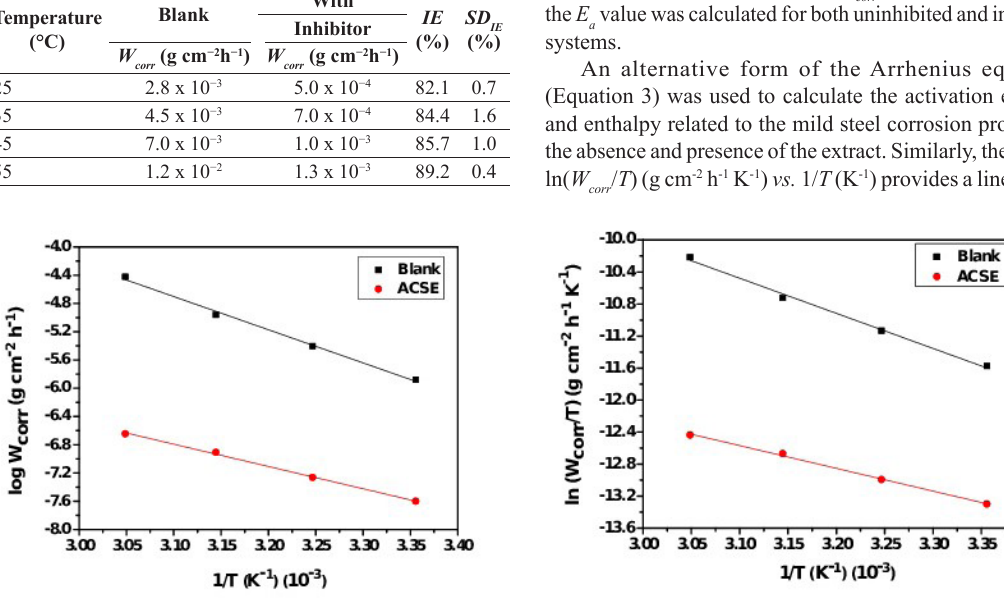
Figure 1. Arrhenius plots of: (A) (log W